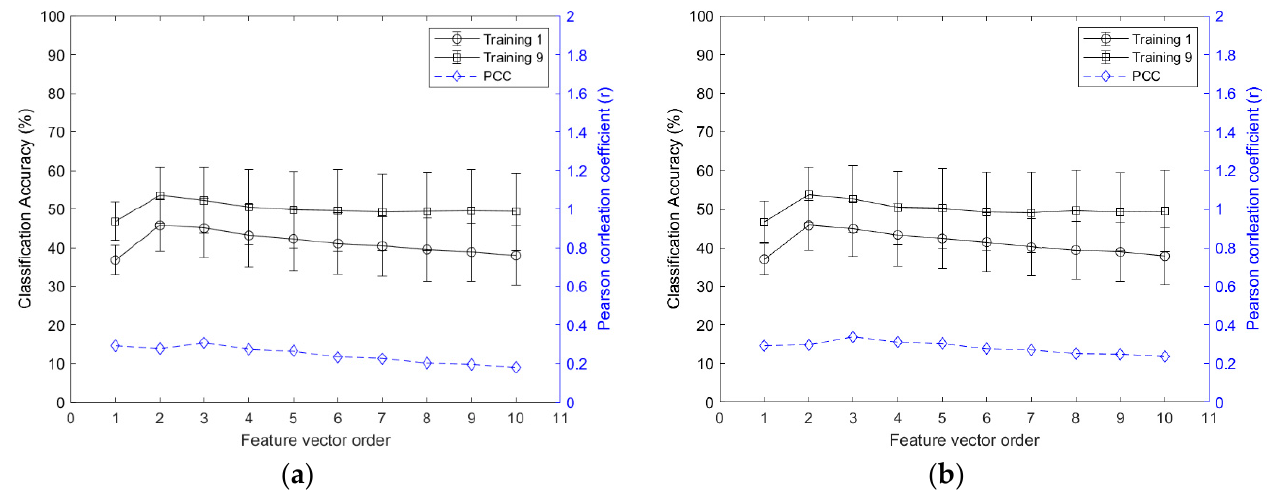
Figure 4. Classification accuracy and inter-session PCC of Group 1 based on the orders: ( a ) AR; ( b ) CC.